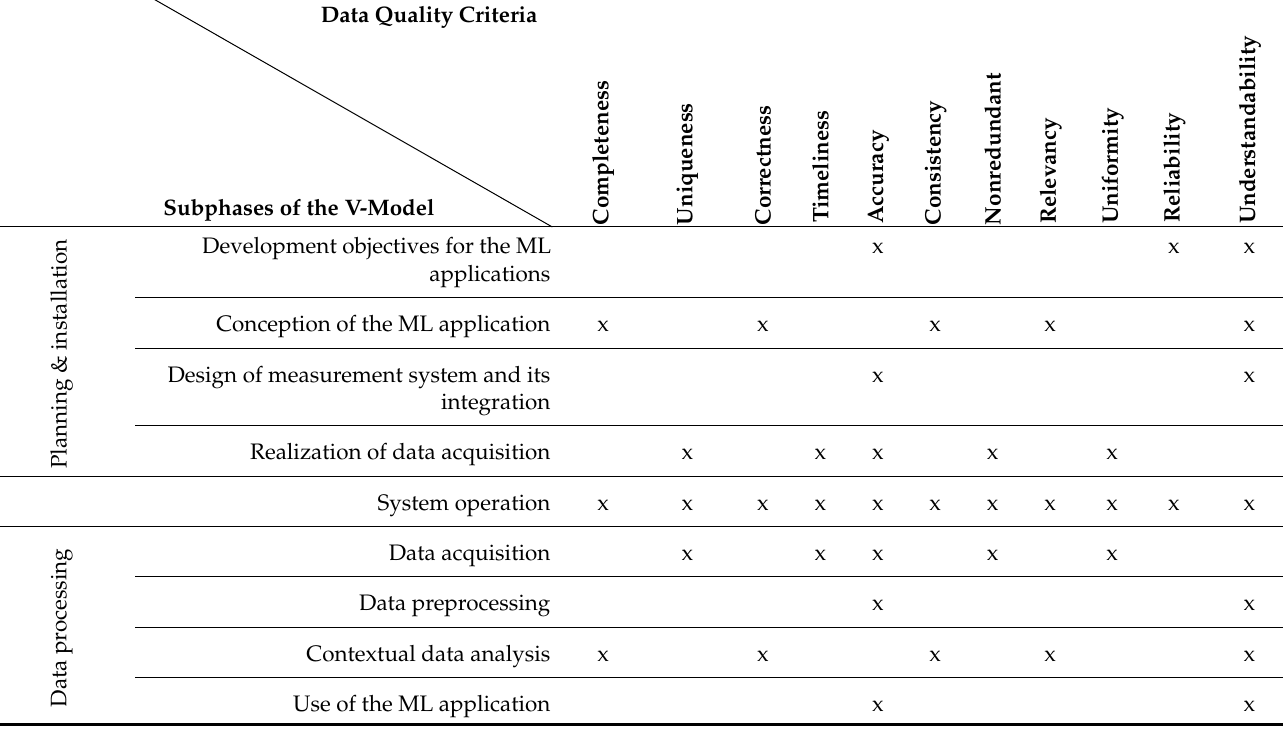
Table 2. Assignment of data quality criteria to the activities in the steps of the V-Modell.